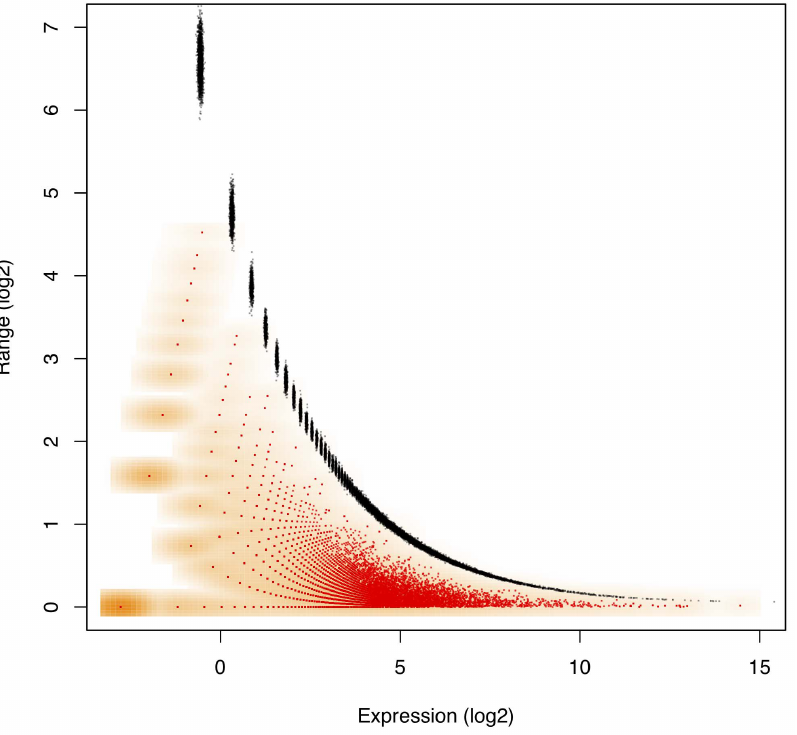
Figure 1. Dirichlet-distributed proportions accurately account for the sampling variance. This plot overlays the expected range between the 1–99% quantiles for q i with observed range of E f q i g computed for the Liver library replicates in the L–K dataset. Marioni et al[19] minimized technical error with an experimental design where the same Illumina library was run in two separate lanes. Monte Carlo Estimates of E f q i g are shown in red with the density of the values shown in orange, while 1–99% expected quantile ranges from the Dirichlet are shown in black. This demonstrates that the error inherent in high-throughput sequencing is greatest when the counts are small and least when the counts are large. The near-perfect overlay of actual and modelled values strongly support idea that modelling proportions through a Dirichlet-multinomial process accurately accounts for the sampling variance inherent in RNA-Seq, and by extension in other high-throughput sequencing analyses. The error in estimating the expected quantiles is observable by the size of the points plotted in black and becomes small when expression is non-trivial. Values on the x -axis were calculated with the given formula for E f log( p i ) g and were adjusted to remove the non-informative subspace as outlined in the text. Thus the x -axis value of zero corresponds to the expected per-gene log 2 -expression